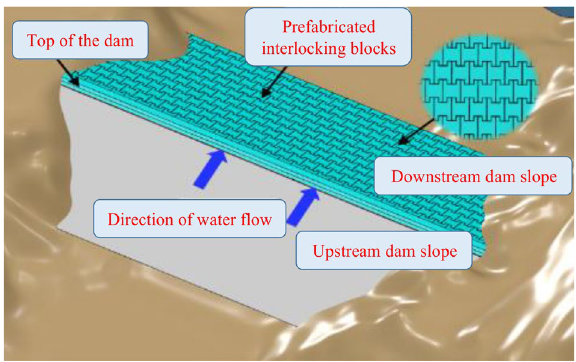
Figure 10. Full-coverage protection technology for prefabricated interlocking blocks.